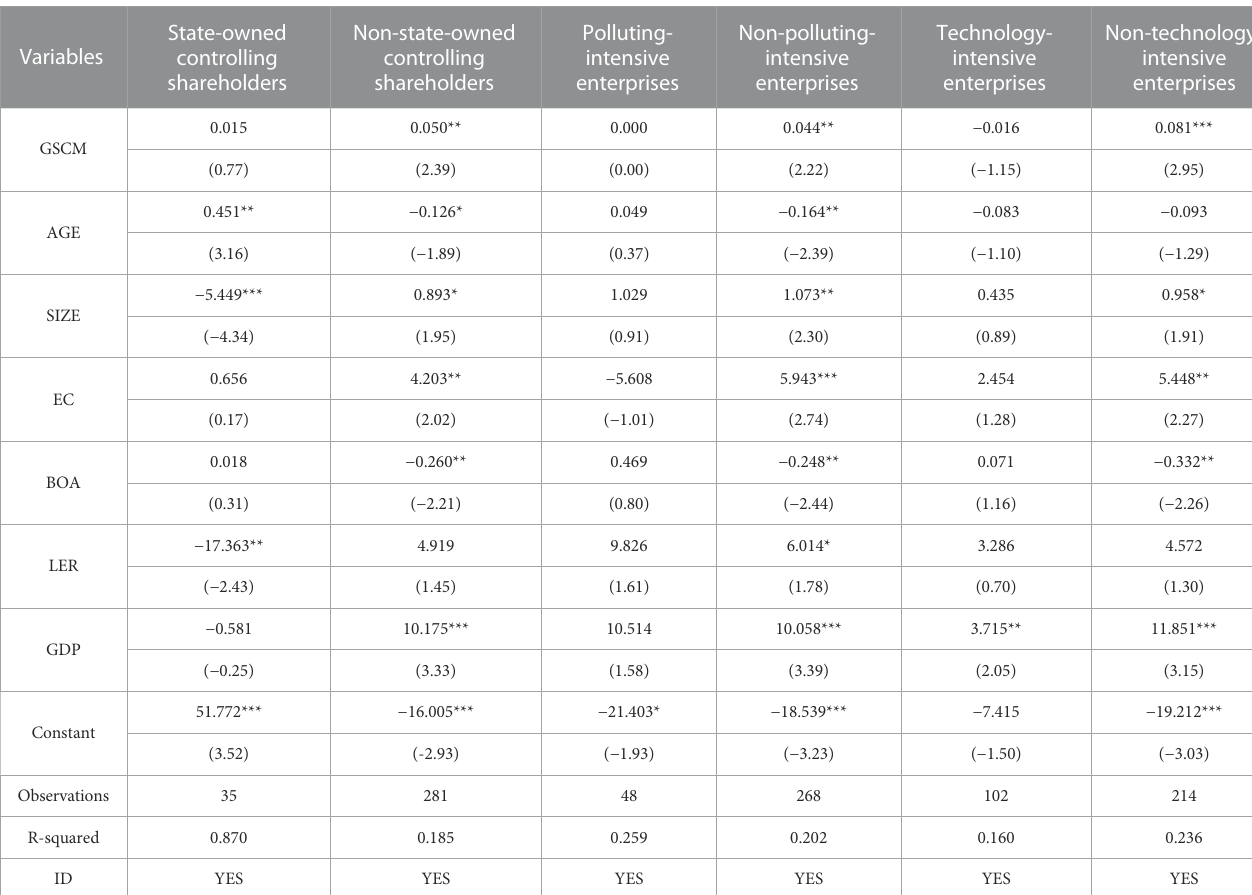
TABLE 4 Heterogeneity